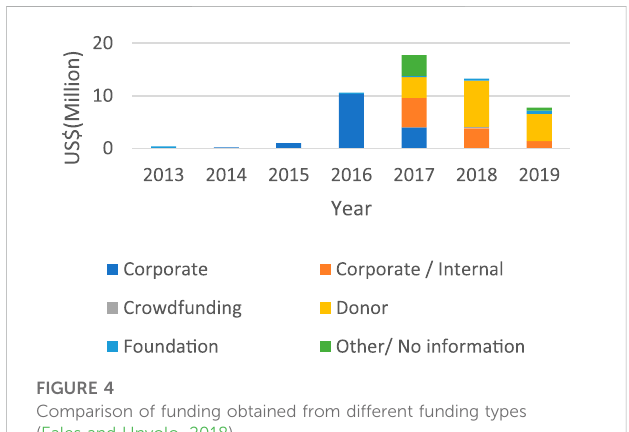
FIGURE 4 Comparison of funding obtained from different funding types (Eales and Unyolo,